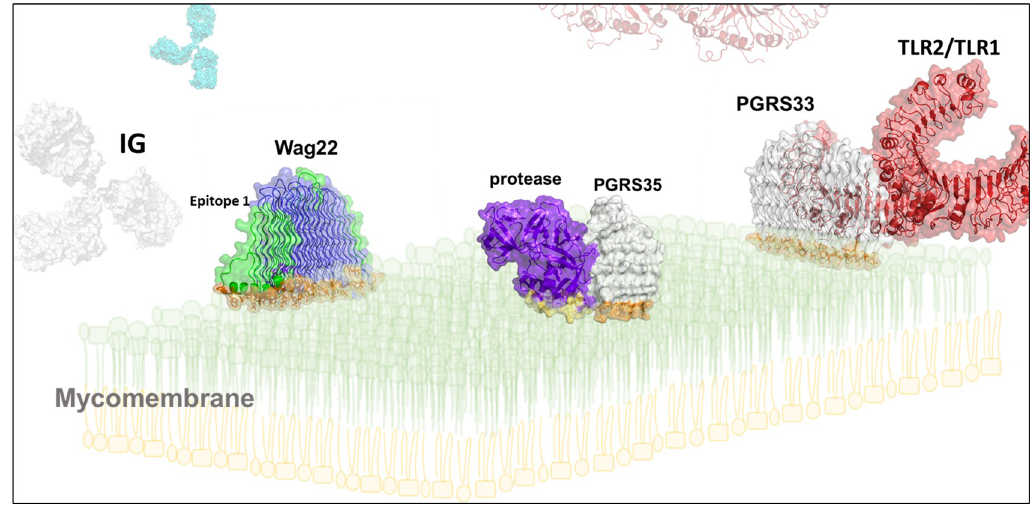
Fig 2. A speculative drawing of PE_PGRS33 (white), − 35 (white-prune), and Wag22 (blue-green) proteins sailing the mycomembrane. TLR2 (pdb code 6nig) was docked on PGRS33 structure by combining surface complementarity, using the software PatchDock, with refinement of electrostatic interactions and desolvation energy, using FireDock. Structure-based B cell antigen prediction was performed using ElliPro.